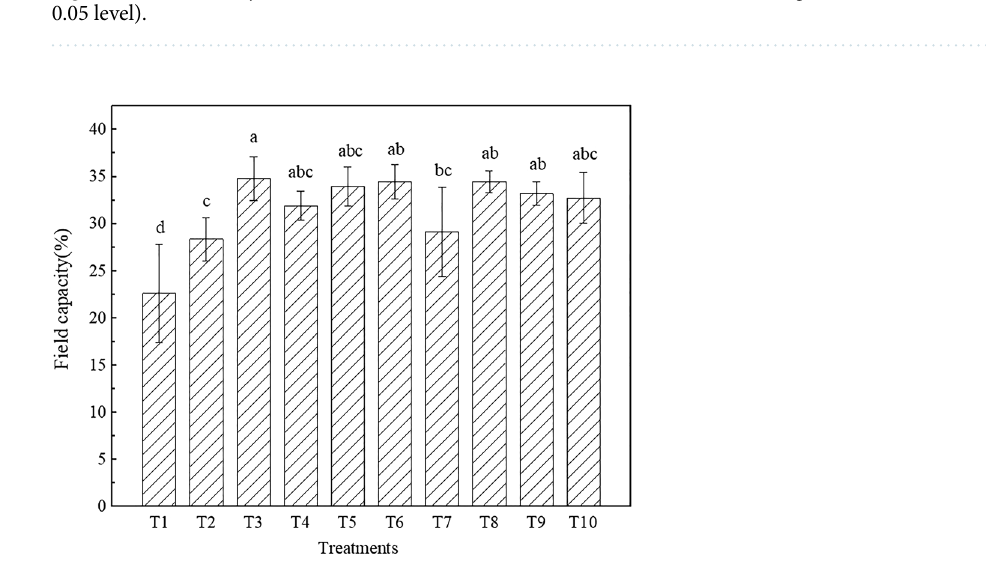
Figure 5. Field capacity under the different treatments (the different letters denote significant differences at the 0.05